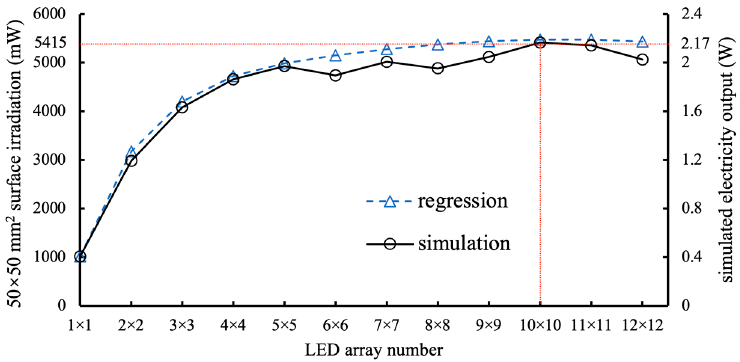
Figure 4. Irradiation power and corresponding electricity output with different LED numbers.